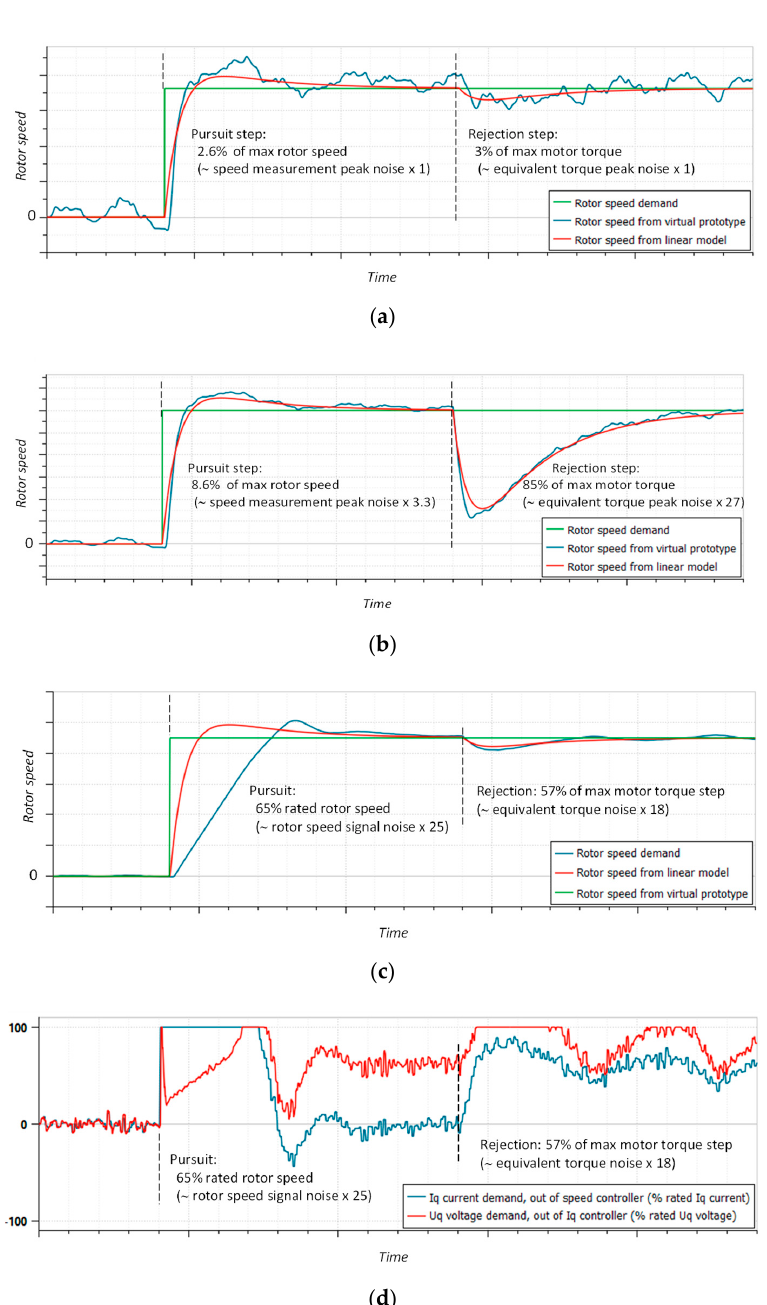
Figure 9. Time response of the speed loop for step excitations: ( a ) small-magnitude excitations, noise effects magnified; ( b ) medium-magnitude excitations, at the limit of saturation; ( c ) large-magnitude excitations, introducing long saturation of the current and modulation ratio; and ( d ) the speed and current controller outputs for large-magnitude excitations.